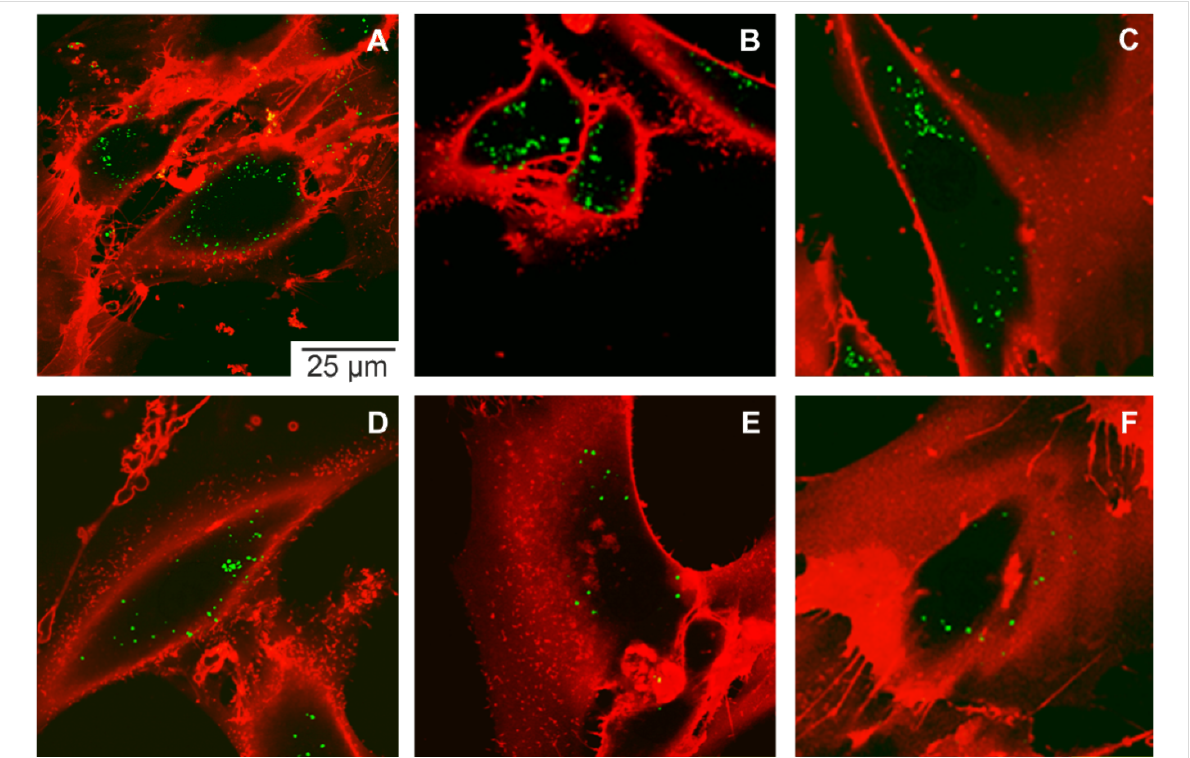
Figure 2: CLSM images of cells treated with PLLA/magnetite particles; incubation time: 24 h; pictures taken at specified times after particle addition: A) 24 h, B) 48 h, C) 72 h, D) 5 d, E) 7 d, and F) 14 days. Red: cell membrane; Green: PLLA nanoparticles.